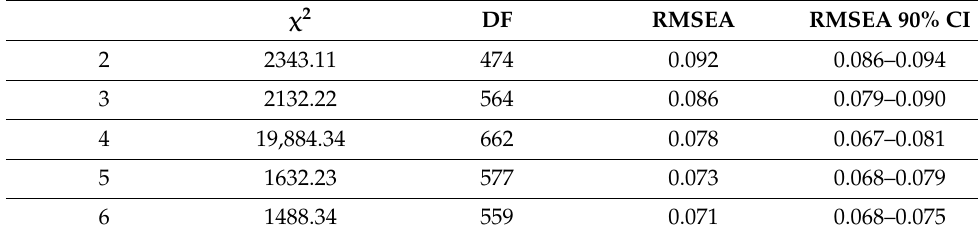
Table 8. Comparison of Factors’ Fit.